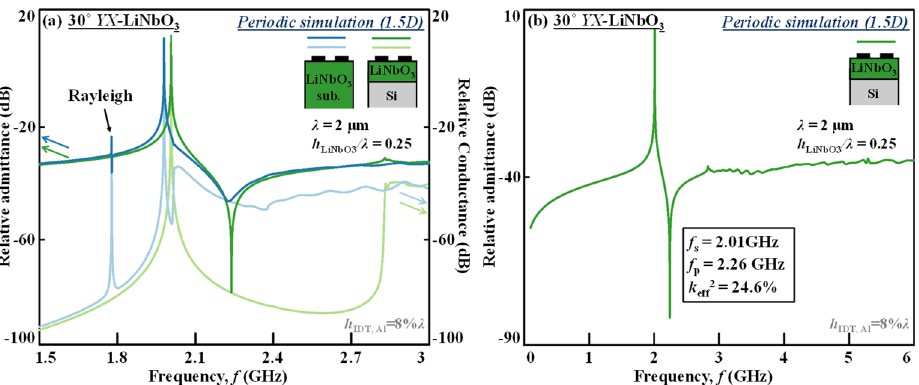
Figure 4. FEM-simulated ( a ) narrow-band response compared to LiNbO 3 substrate, and ( b ) wide- band response of the SH resonators with periodic structure (1.5D model) based on LiNbO 3 /Si with 30° YX LiNbO 3 and h LiNbO3 / λ = 0.25.